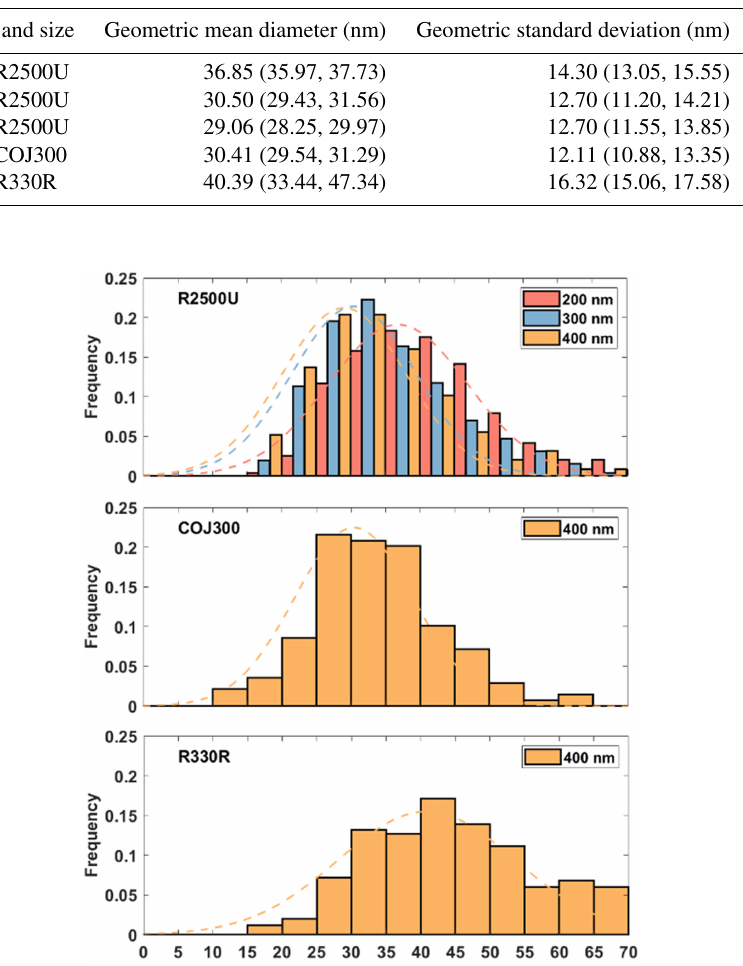
Table A1. Coefficients and goodness for the normal primary particle size distribution fit. The 95% confidence intervals are enclosed in parentheses.